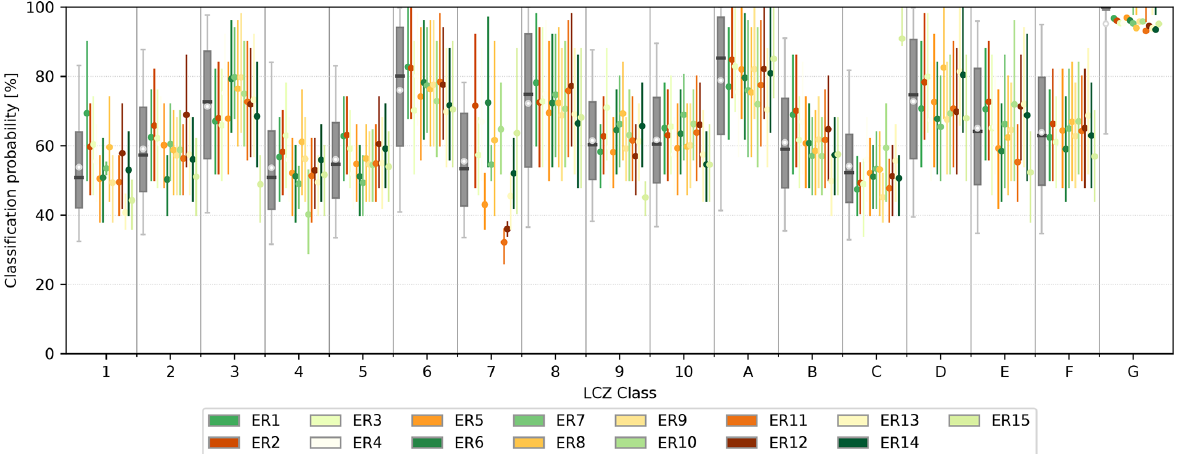
Figure 9. Classification probabilities of the mapped LCZ classes, aggregated over all urban centres from GHS-UCDB. The grey boxplots depict the classification probability distribution for all global urban centres, per LCZ class, with boxes and whiskers spanning the 25th–75th and 5th–95th percentiles respectively and means and medians indicated by the white dots and black lines respectively. The vertical lines in the colours of the urban ERs (colour legend as in Fig. 3) indicate the 25th–75th percentile range averaged over the urban centres, stratified per ER. ER-coloured dots indicate the mean. Results stratified per urban ecoregion are available in Appendix H.